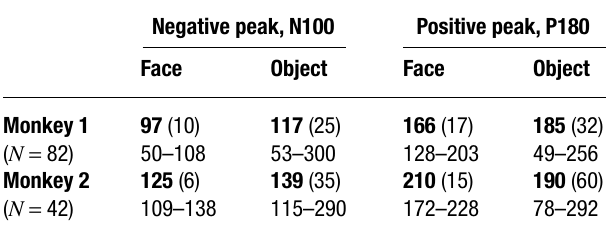
Table 1. Latencies of the two main LFP components in auditory cortex for face and object categories.